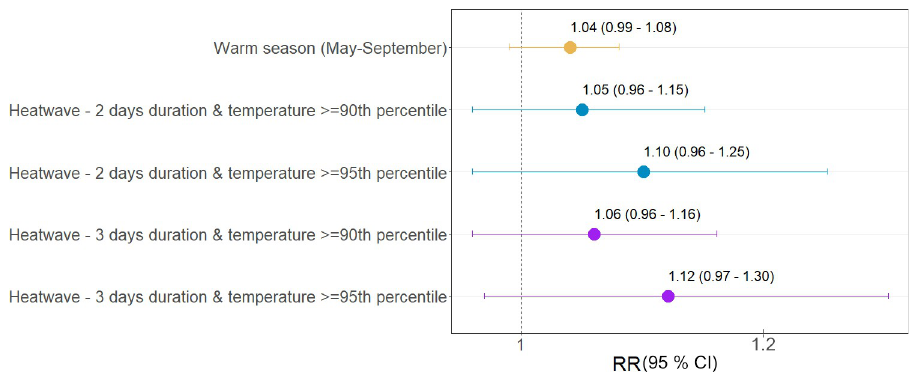
Fig 4. Relative risks (RR, 95% confidence interval) of mental disorders hospitalizations per 10 C increase in daily mean temperature during the warm season (May-September) and heatwaves. Null hypothesis is that there is no association (RR = 1), thus one can reject the null hypothesis when 95% confidence interval does not include 1.